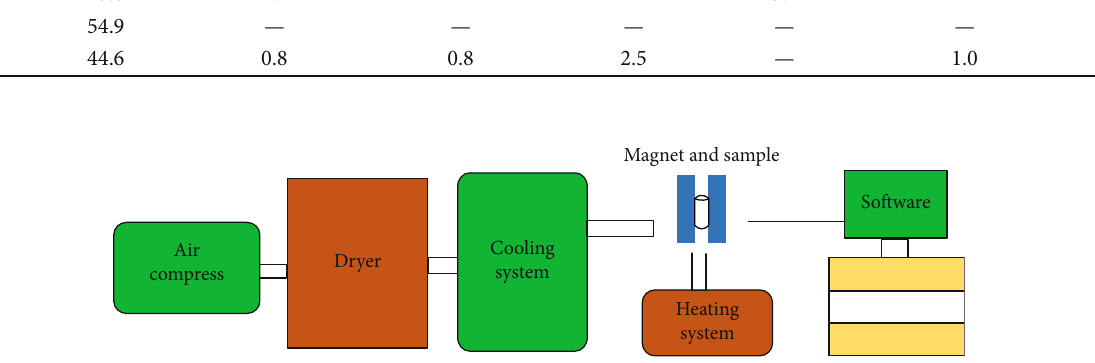
Figure 2: The sketch of the NMR cryoporometry analysis system.